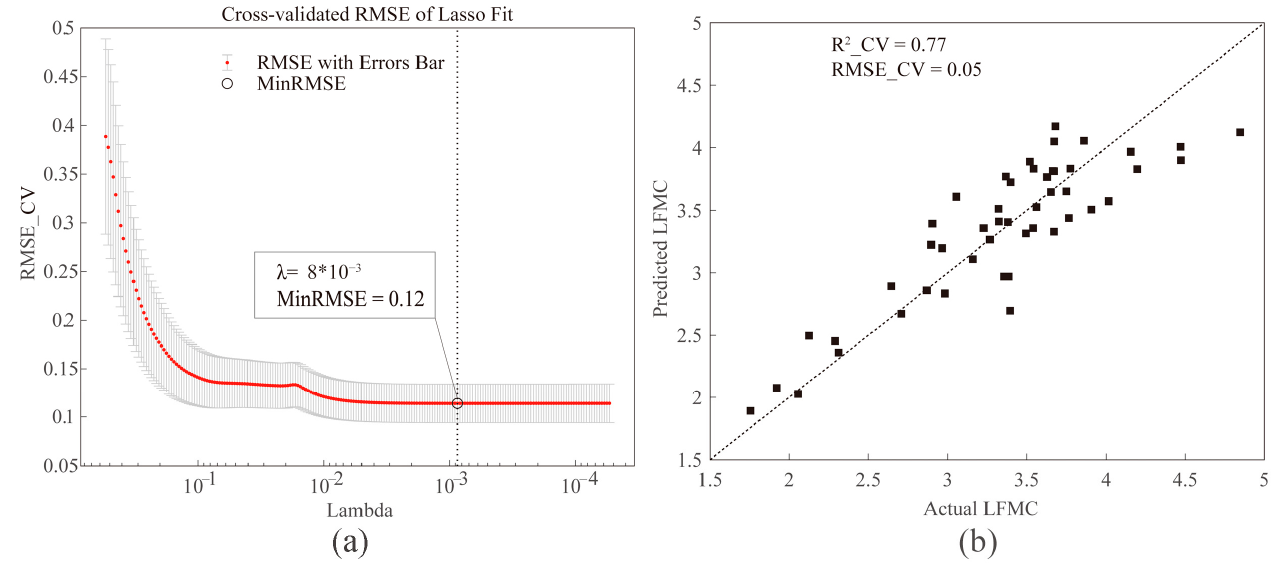
Figure 7. ( a ) Use of 10-fold cross-validation to determine the regular coefficient (lambda, λ ) of the Lasso model; ( b ) predicted and actual values of LFMC by Lasso regression.